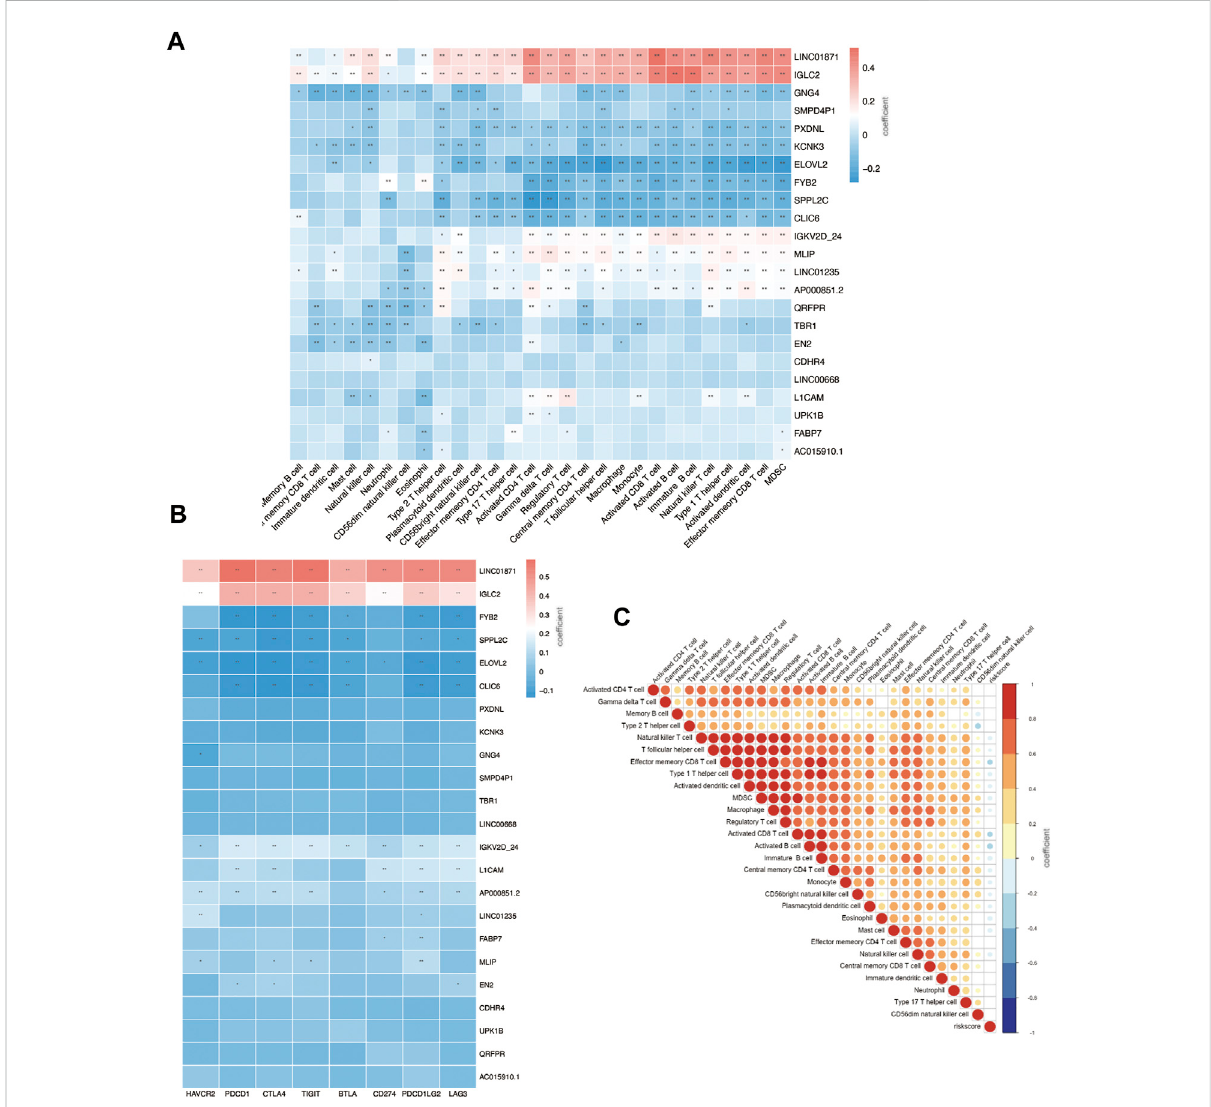
FIGURE 8 Immune in fi ltration status of prognostic signature. (A) Risk genes level in high- and low-risk groups. (B) Correlation between risk genes and checkpoint molecule expression. (C) Correlation between riskscore and immune in fi ltration.